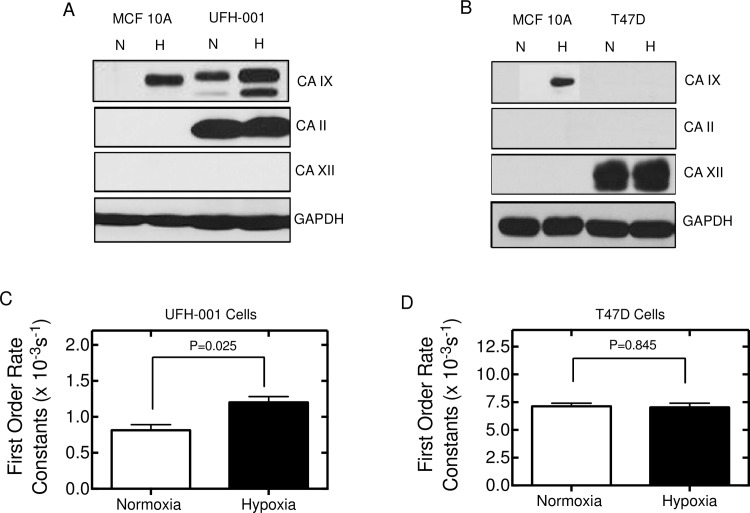
CA expression and activity in breast cell lines.Panel A. Protein expression in a normal immortalized basal type breast cell line (MCF 10A) and a triple negative breast cancer (TNBC) cell line (UFH-001), using western blot analysis (under normoxic (N) or hypoxic conditions (H) for 16 h, respectively). Panel B. Immunoblots for CAs II, IX and XII protein expression in MCF 10A and the luminal ER positive breast cancer cell line (T47D). Panels C and D. UFH-001 and T47D cells were grown for 3 days at which point they were exposed to normoxia or 16 h of hypoxia and the cells assayed for CA IX and XII activity, respectively, using the MIMS assay (see S3A and S3B Fig for a description of a pictorial representation of the MIMS assay). First order rate constants for CA activity in UFH-001 cells (Panel A) and T47D cells (Panel B), as described in the methods, are shown. These data represent three independent experiments and are reported as the mean ± SEM.